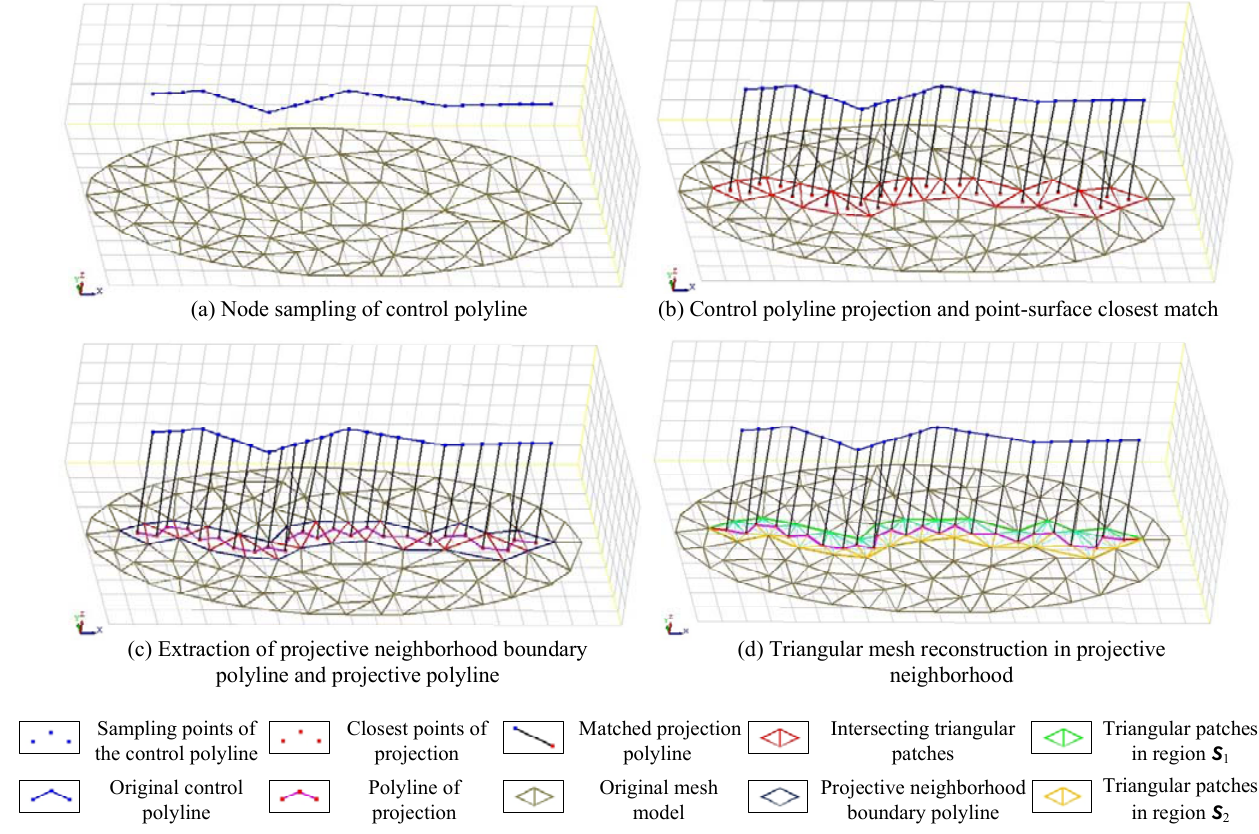
Figure 2. Mesh reconstruction flowchart of the projective neighborhood.